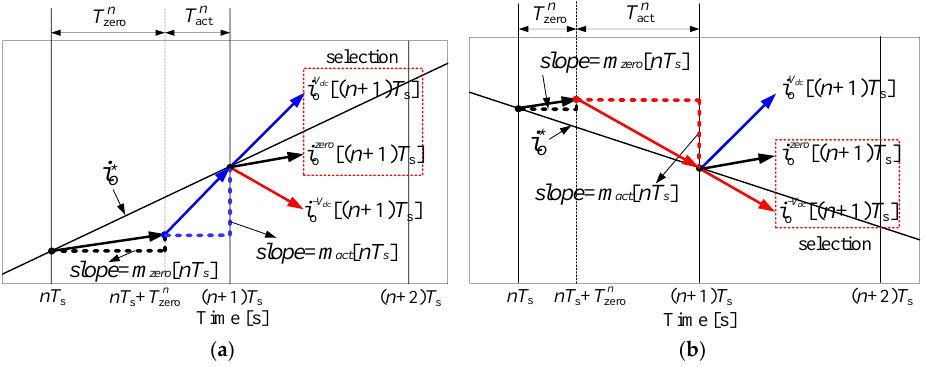
Figure 3. According to reference current slope, two switching state selections ( a ) positive reference slope, ( b ) negative reference slope in proposed method.